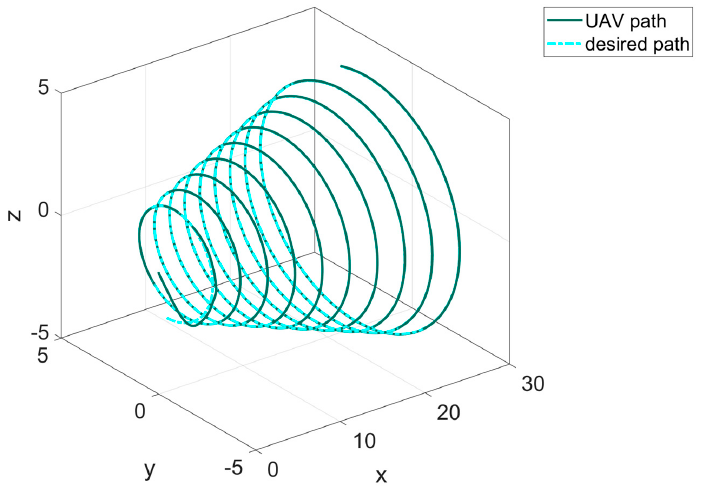
Figure 7. Rotor’s speed under the proposed control plan. Figure 8. Three-dimensional phase plot illustrating the trajectory of the system under the proposed control technique.